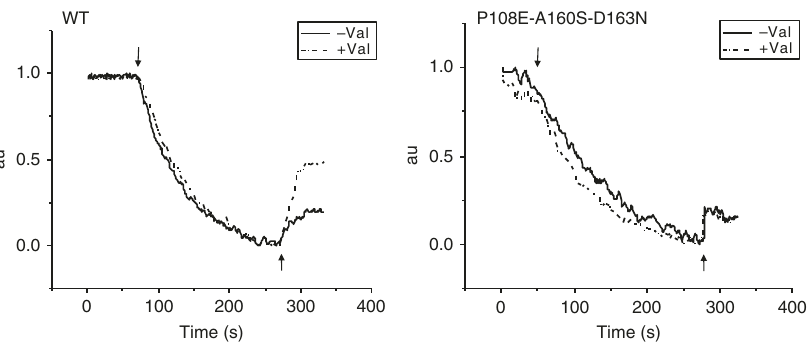
Fig. 6 Valinomycin effect on Na + -induced proton ef fl ux con fi rms electroneutrality. For measuring the Li + /H + antiporter activity in pH 8.5, E. coli EP432 cells expressing WT or the P108E-A160S-D163N mutant were grown in LBK (pH 7.0) and everted membrane vesicles were isolated. The Δ pH across the membranes was determined using acridine orange, a fl uorescence probe of Δ pH. The reaction mixture (2.5 mL) was modi fi ed according to Schuldiner and Fishkes 45 to get the maximal effect of valinomycin (2 µ M). It contained, protein (100 µ g), Tris-Cl (10 mM, pH 7.8), MgSO 4 (10 mM), and KCI (Na +